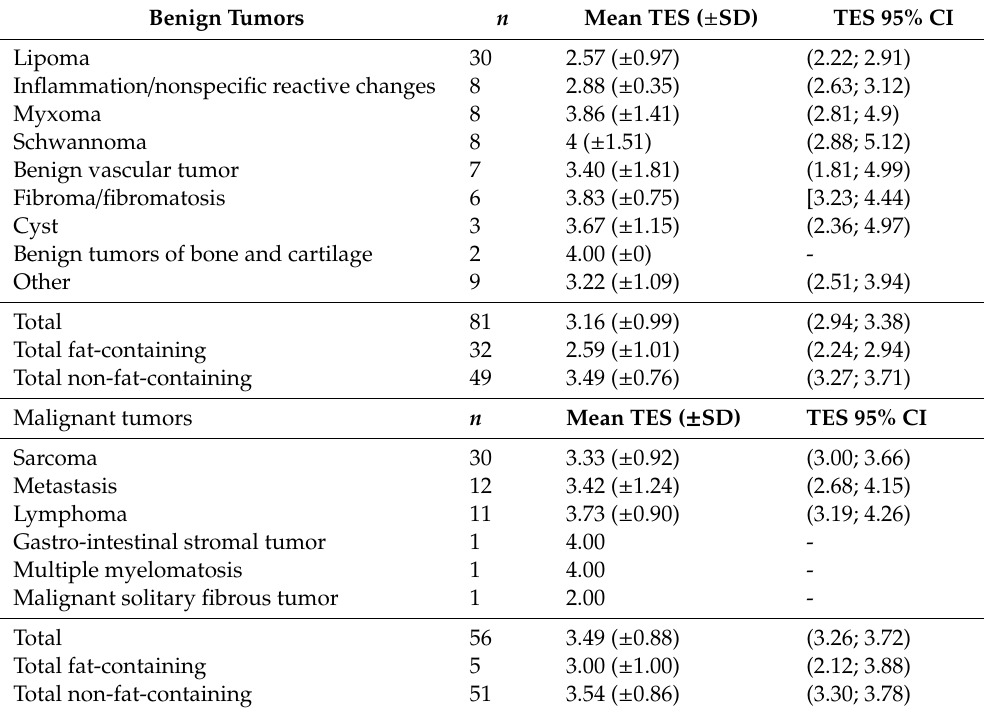
Table 3. Summary of diagnoses, and their respective